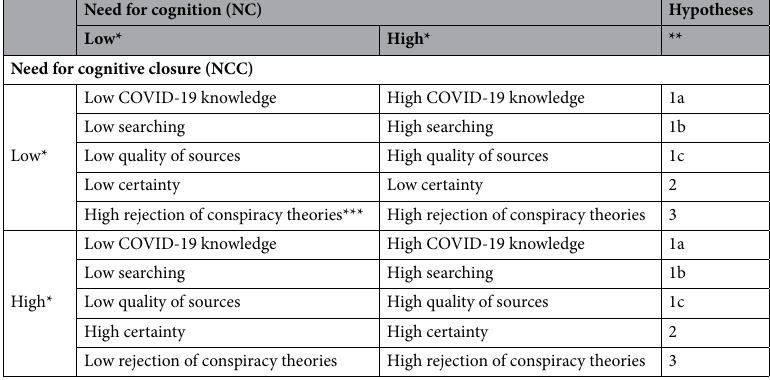
Table 1. Hypotheses regarding COVID-19 Knowledge, conspiracy rejection, and media use based on need for cognition and need for cognitive closure. *Previous studies have categorized NC and NCC scales in ‘high’ and ‘low’ groups, thus dichotomizing continuous scores in statistical analysis 7,13–16. However, categorization is unnecessary for statistical analysis and even has methodological weaknesses 17. That said, labelling participants as high or low groups does allow for a convenient comparison of the outcome variables. To achieve the middle ground, we have chosen to use continuous variables in our statistical analyses, whereas in our